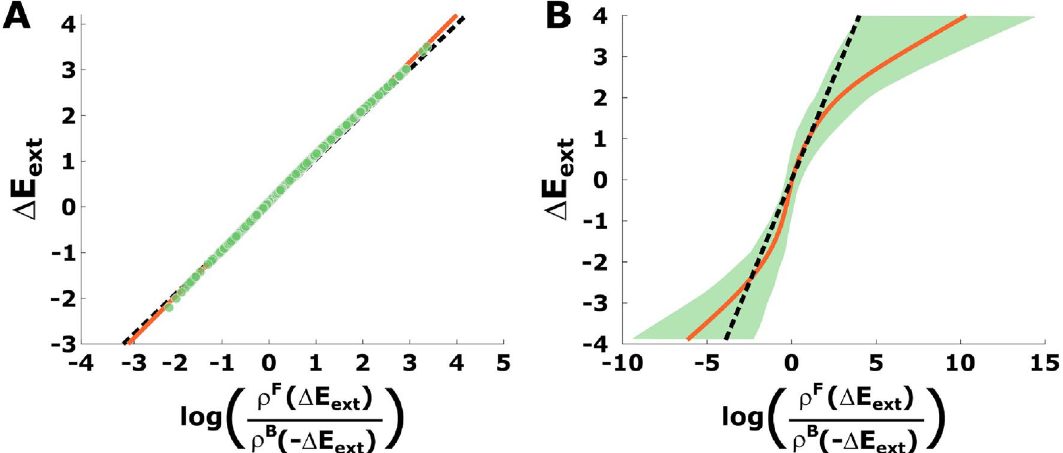
Figure 2. Simulation of Crooks’ fluctuation theorem. ( A ) Simulation with 1000 cycles. In black, the theoretical prediction; in red, the linear regression for the simulated data and, in green, the simulated points. Since the simulated data set adjusts pretty well to Crooks’ fluctuation theorem (4), Jarzynski’s equality (5) is fulfilled. ( B ) Simulation with 20 cycles and bootstrapping. The black line is the theoretical prediction (4) while the red line and shaded area are, respectively, the mean and the 99 % confidence interval of (4) after 1000 bootstraps of the driving error values obtained in a single run (which consists of 20 simulation with 1000 cycles in Fig. 2A, where we can see a good adjustment between the theoretical prediction (in black) and the linear regression of the observed data (in red). As a result, (5) also holds in this scenario. The more critical question is what happens when only few samples are available. To this end, we use the stochastic optimization algorithm to simulate the protocol of our experiment, that is, 20 cycles, and indicate confidence intervals using 1000 bootstraps. It can be seen in Fig. 2B that the theoretical prediction is consistent with the 99%